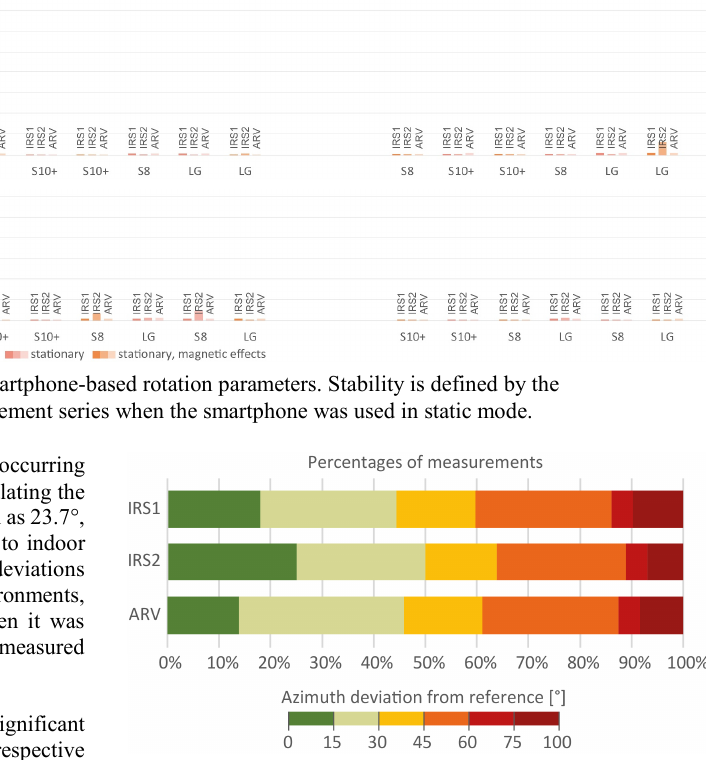
Figure 5. Histograms of the total deviations regarding azimuth in relation to the measurements from IRS1, IRS2 and ARV.